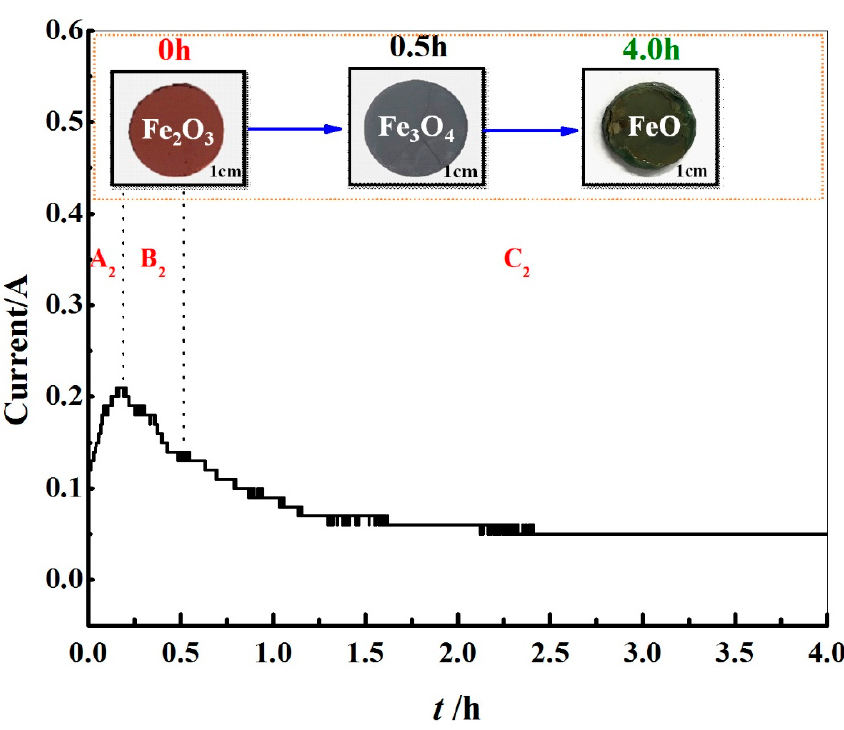
Figure 9. I – t curves of electrolysis of S 2 (mFe 2 O 3 /mAl 2 O 3 = 3:2, at 2.3 V, 850 °C, and 4 h).